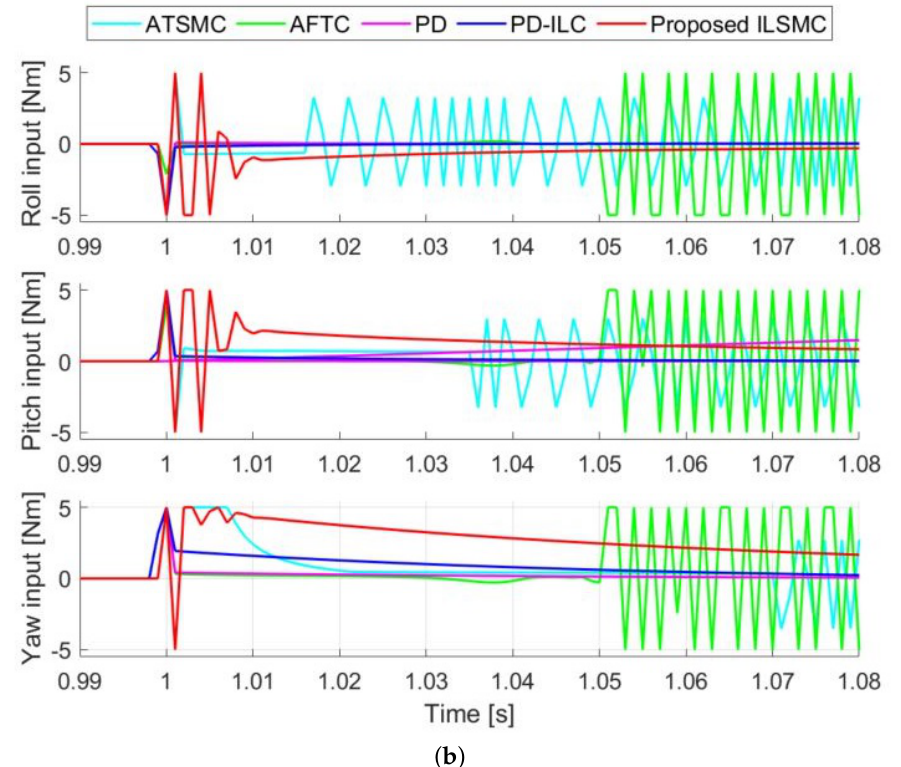
Figure 4. Step response in nominal conditions: ( a ) step response and ( b ) control